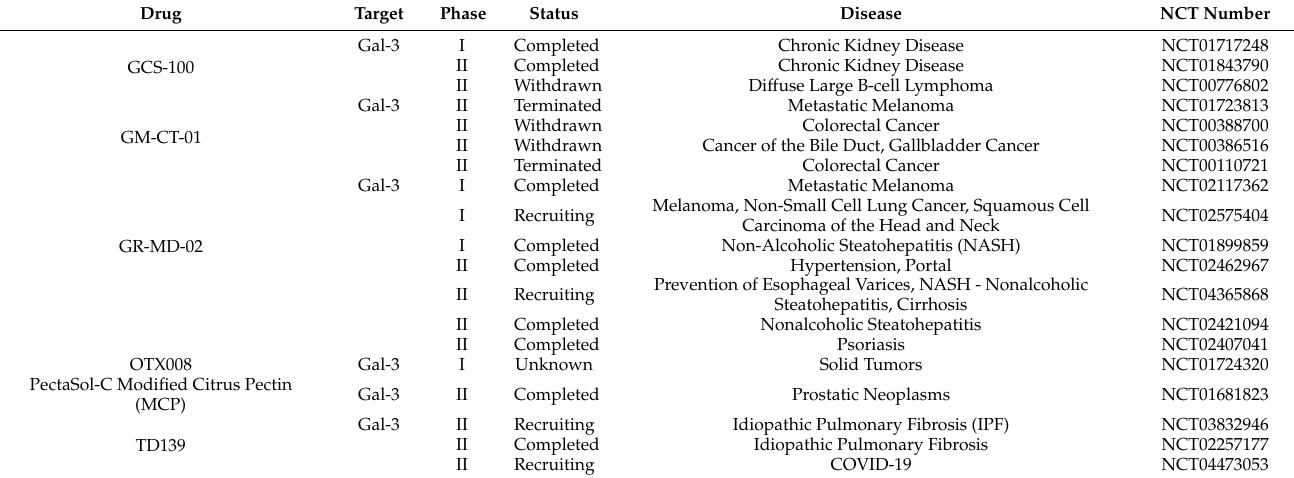
Table 6. Galectin-related ongoing clinical trials.